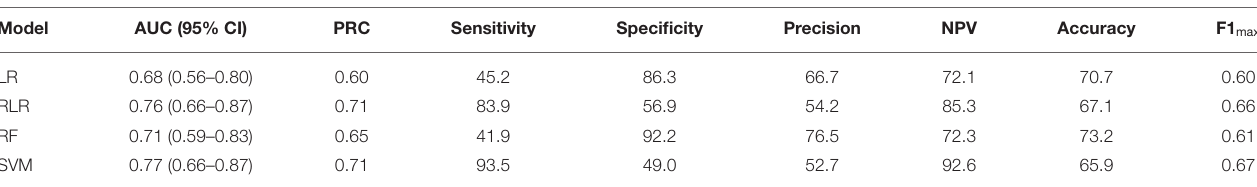
TABLE 6 | Scores for each algorithm of model 2 in external validation cohort.